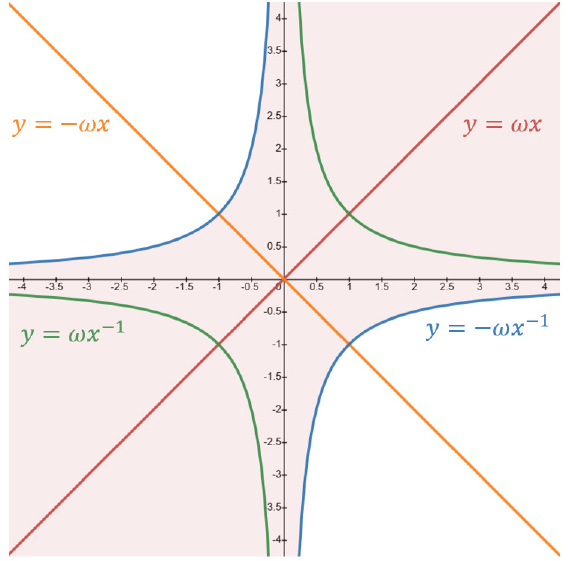
Figure 2. Graphic curves of power functions in a pair of opposite signs with 1 and − 1 being exponents. Shadow region signifies a general orientation for y = ω x to reach tangency with y = − ω x − 1